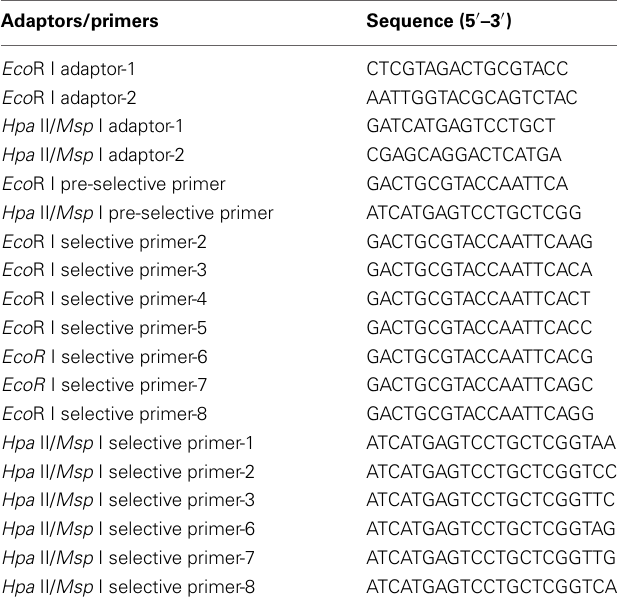
Table 2 | Sequences of adaptors and primers used for MSAP analysis.